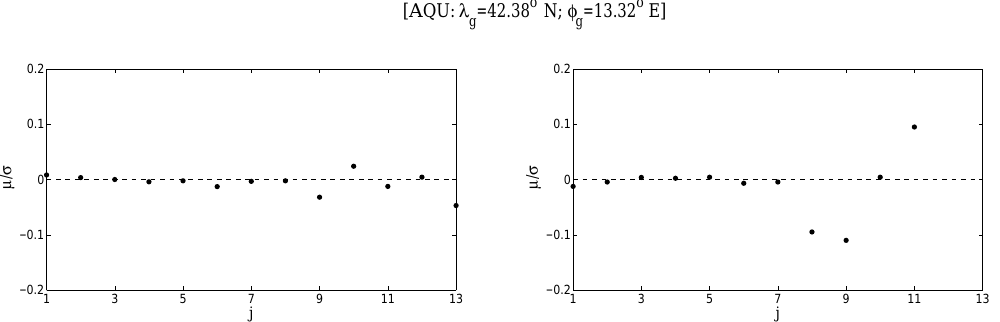
Figure 3. SSQ, 10–12 October 2003: SMT applied to the EMD reconstruction of the ground observations for the H (left panel) and D (right panel) components. The x axis is order in terms of the last mode involved in the partial sums (see Eq. 8).